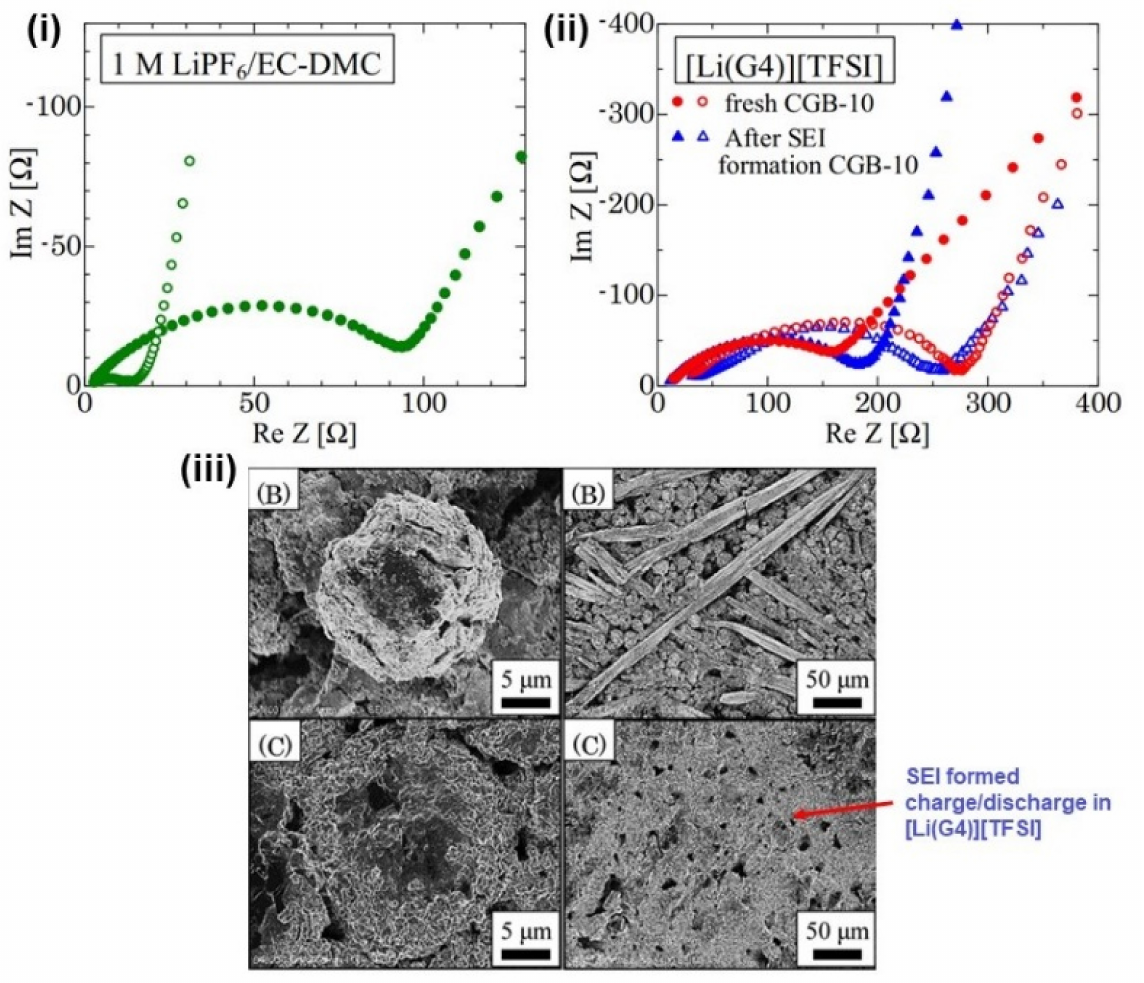
Figure 23. ( i , ii ) Impedance spectra of Li anode immersed in LiPF 6 and LiTFSI electrolytes. ( iii ) Microscopic images of formed SEI (B) Graphite modified [Li(G4)][TFSI] surface after charge-discharge cycles (C) Formed SEI on [Li(G4)][TFSI] (adapted with permission from [216]. J. Electrochem Soc.,